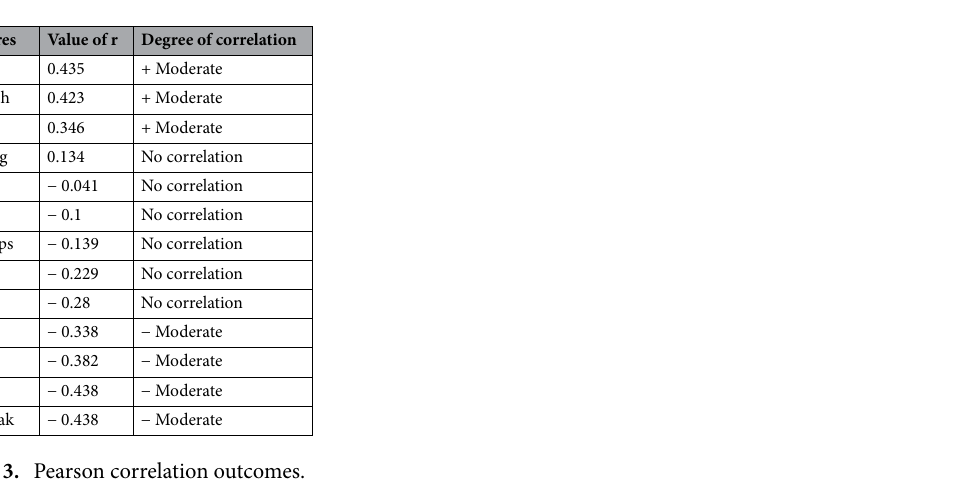
Table 3. Pearson correlation